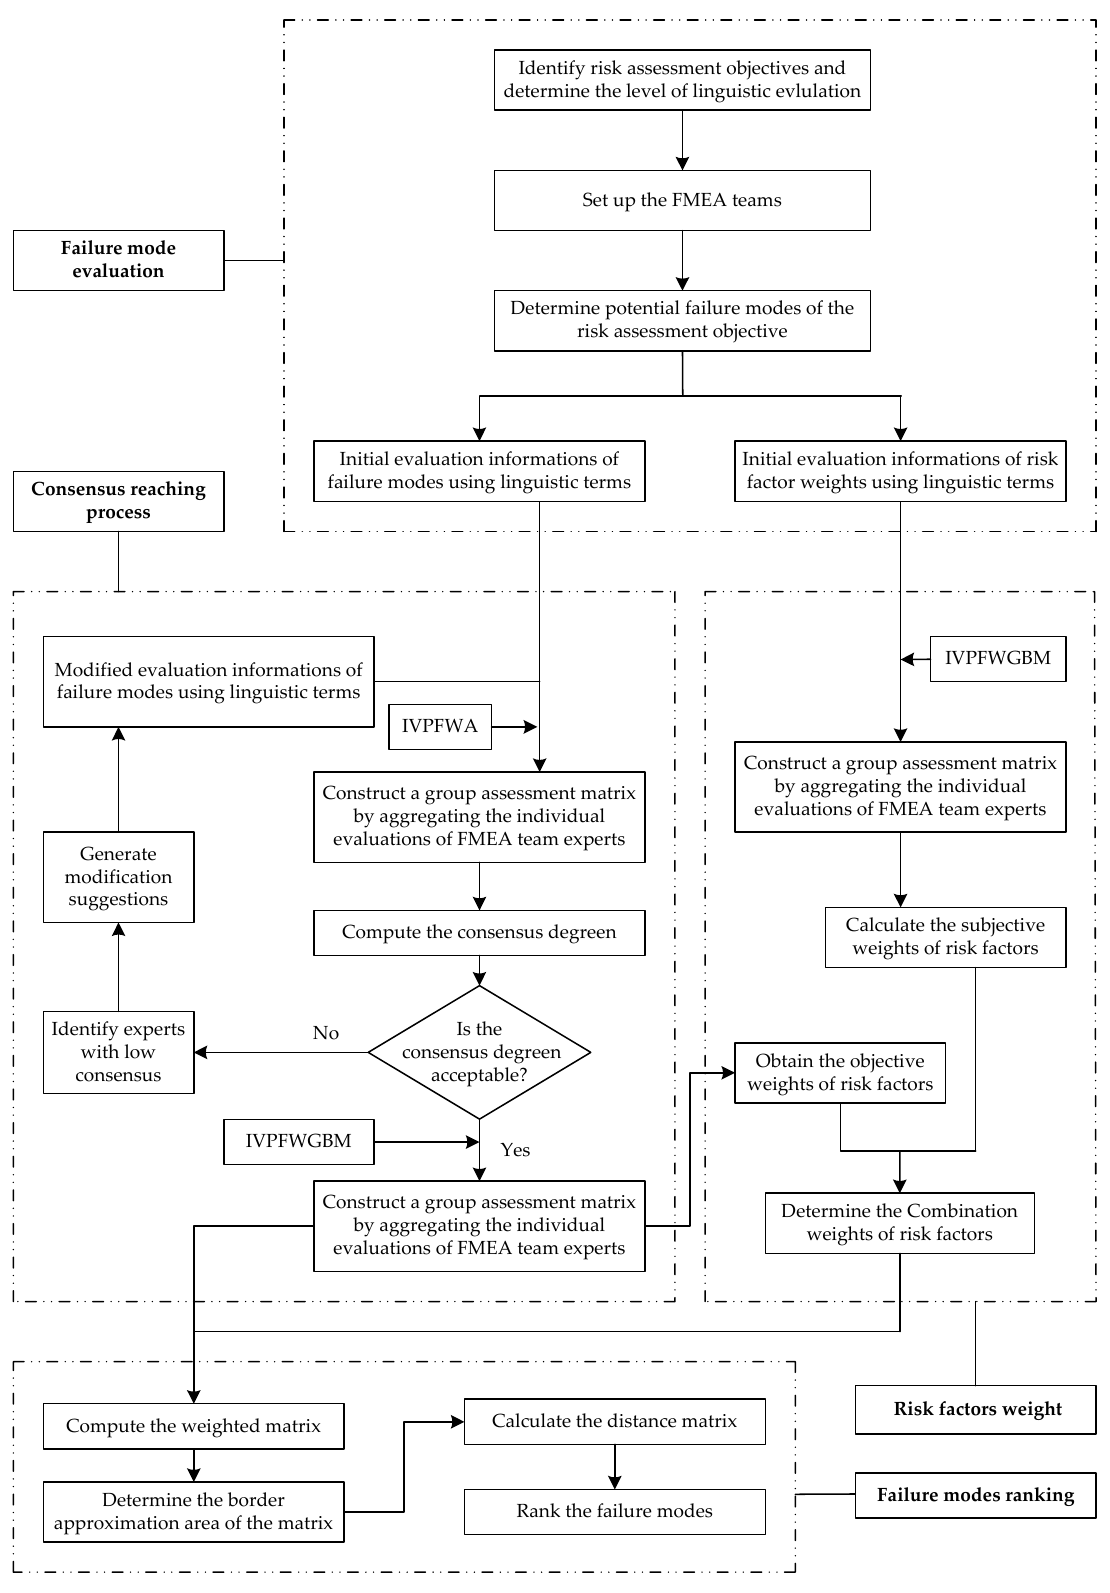
Figure 1. The flowchart of the proposed method. FMEA: failure mode and effects analysis; IVPFWA: interval-valued Pythagorean fuzzy weighted averaging; IVPFWGBM: interval-valued Pythagorean fuzzy weighted geometric Bonferroni mean.